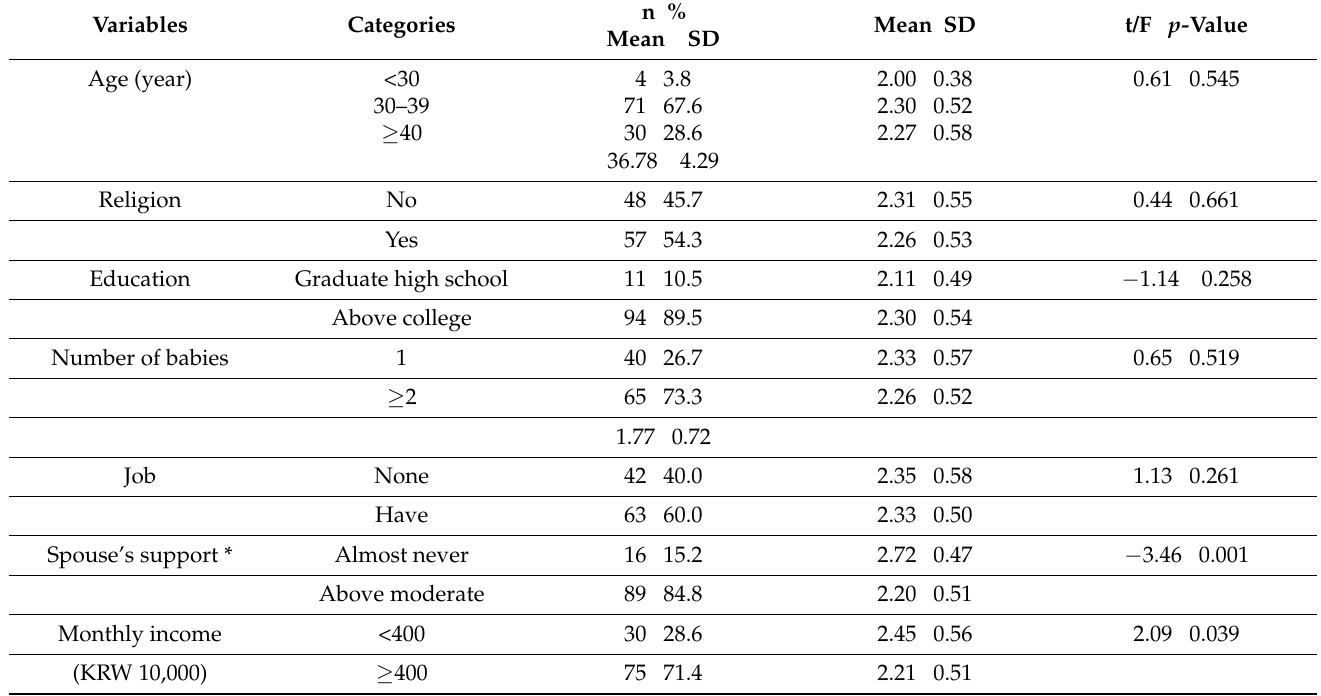
Table 1. Differences in burnout according to general characteristics.